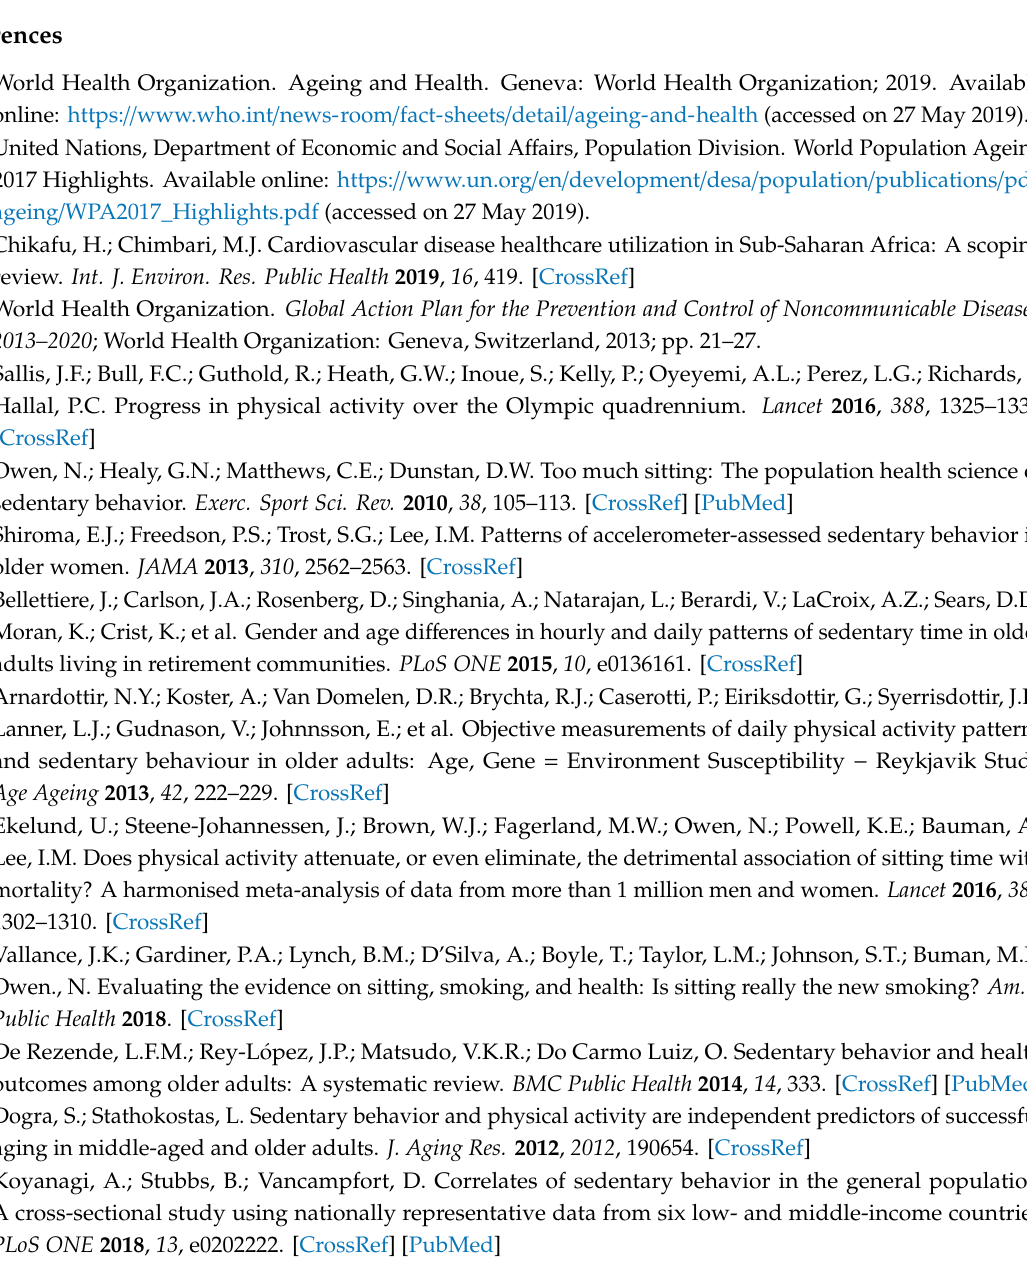
Table S1: title. Associations between perceived neighborhood environment attributes with sedentary time (min / day) on a weekday and a weekend